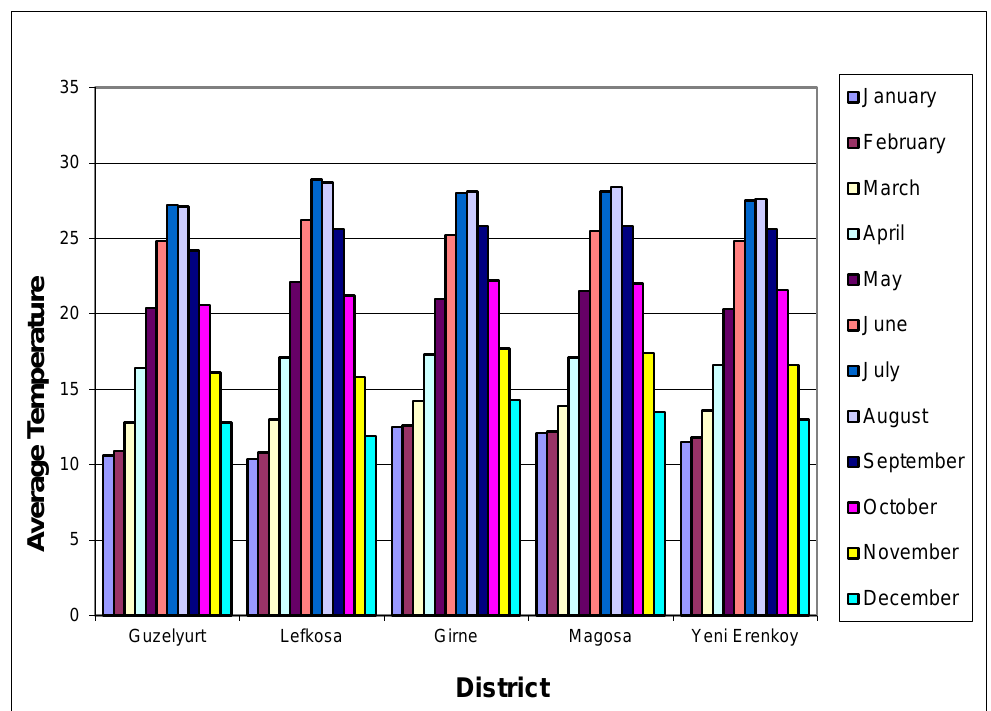
Figure 2. Average monthly temperature variations based on districts of NC, in the years from 1975 to 2001 (°C). Water 2019 , 11 , 191